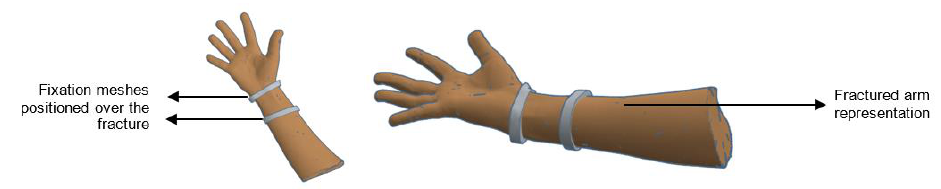
Figure A1. Flexible fixation mesh made of TPU to fill the fractured area.